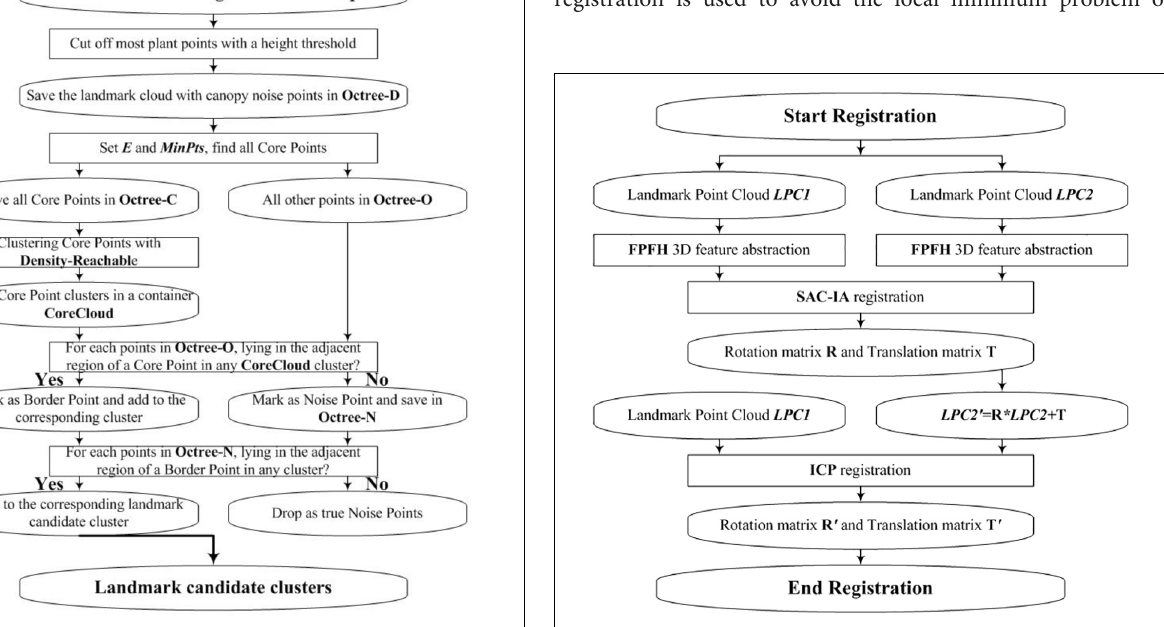
FIGURE 7 | Flowchart for DBSCAN and Octree based landmark detection. FIGURE 8 | Flowchart for virtual-landmark-based